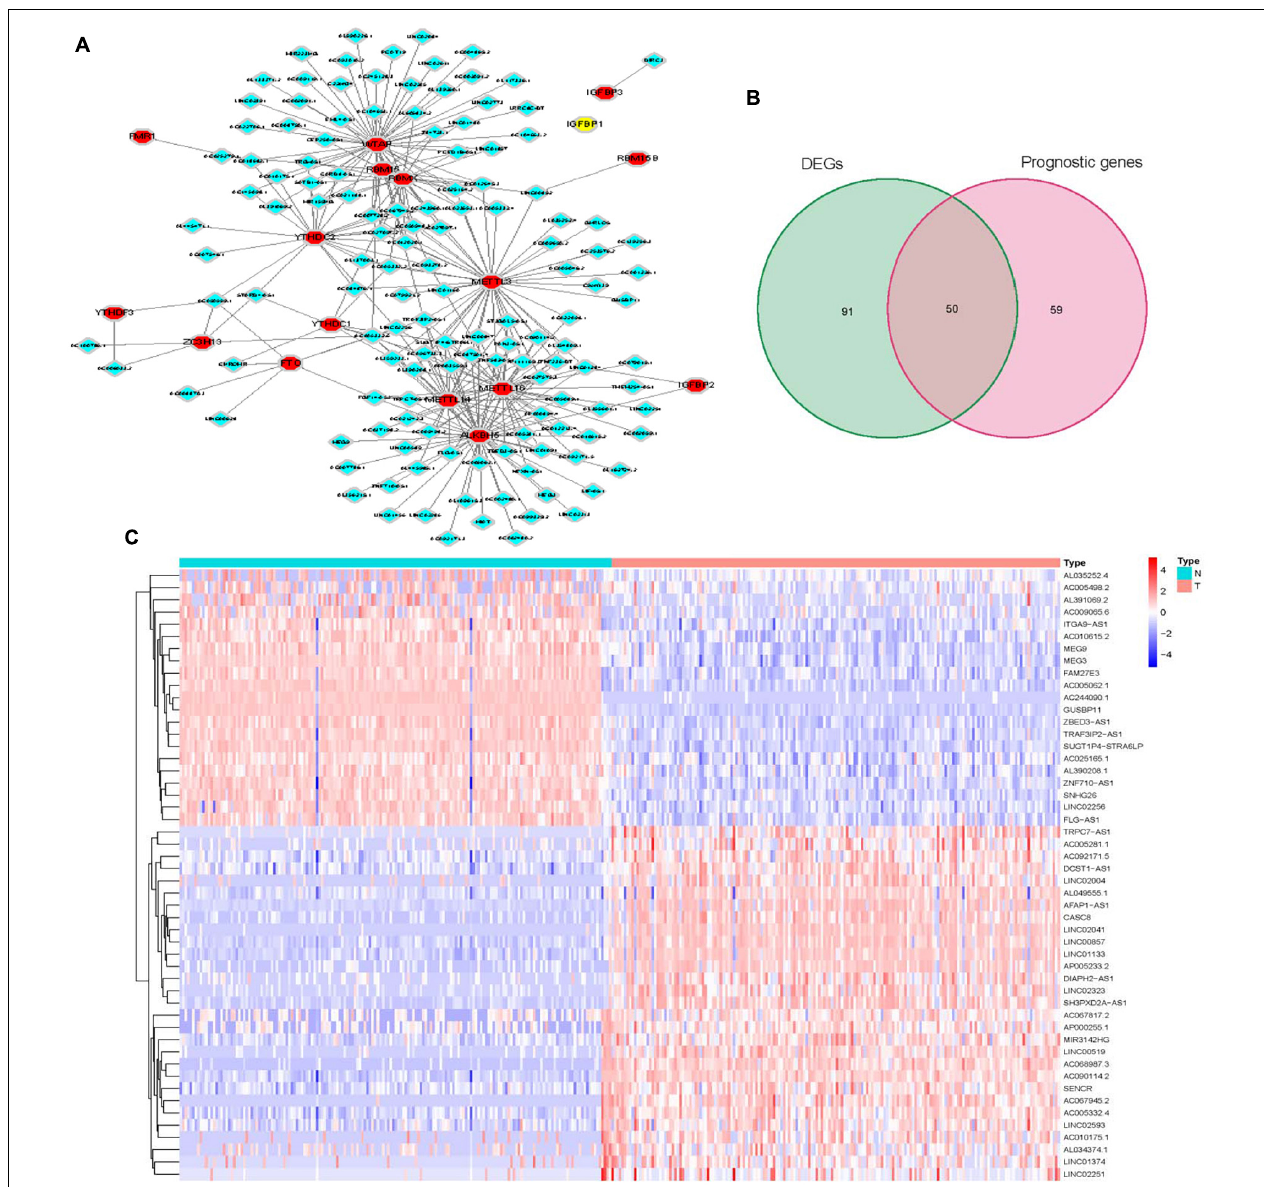
FIGURE 1 | Identification of m6A-associated lncRNAs in pancreatic cancer. (A) Co-expression network of m6A regulatory genes and related lncRNA. (B) Venn plot of differential and prognostic m6A-associatedlncRNAs. (C) Heatmap for prognosis related differential m6A-lncRNAs (hub genes).